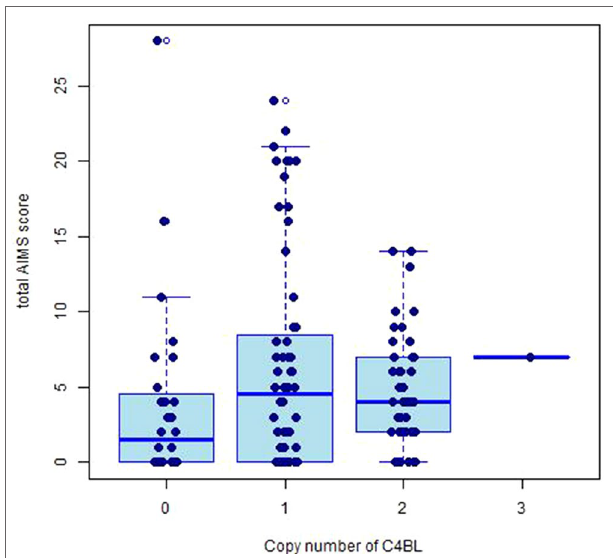
FIGURe 2 | Box plot displaying the distributions of total AIMS scores for copy numbers of C4